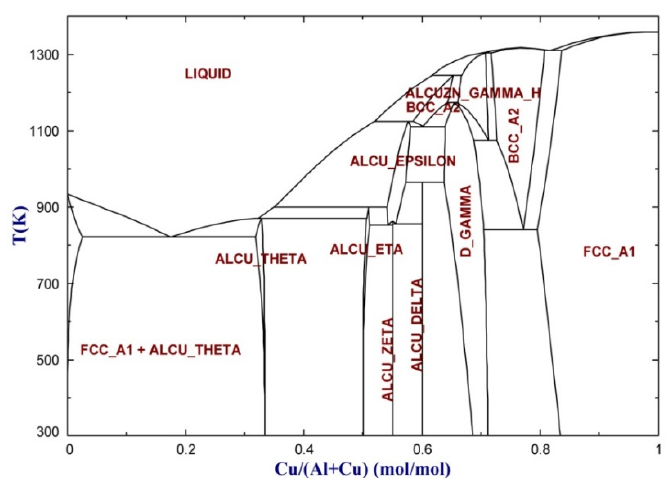
Figure 5. Cu-Al phase diagram from FactSage 7.3 databases [32].